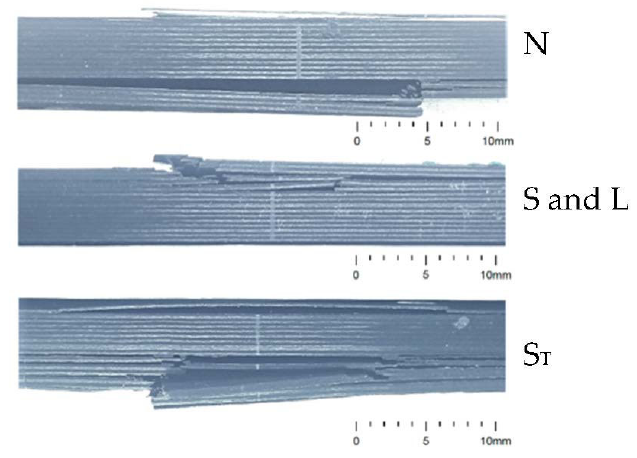
Figure 11. A side view showing damage occurring in different types of specimens [36]. For baseline specimens that had no sensor embedded (N) this damage on the com- pressive side is protracted up to near the fourth lamina before gross failing in the tension side, including delamination and fibre breakage in three of the specimens. In one of the specimens of type N, failure occurred solely on the compressive side close to the loading tabs. For specimens failing on the tension side, this location was between 8 mm and 21 mm from the centre of the specimen. manner reaching from the top surface to the laminae that contained the embedded sensor.